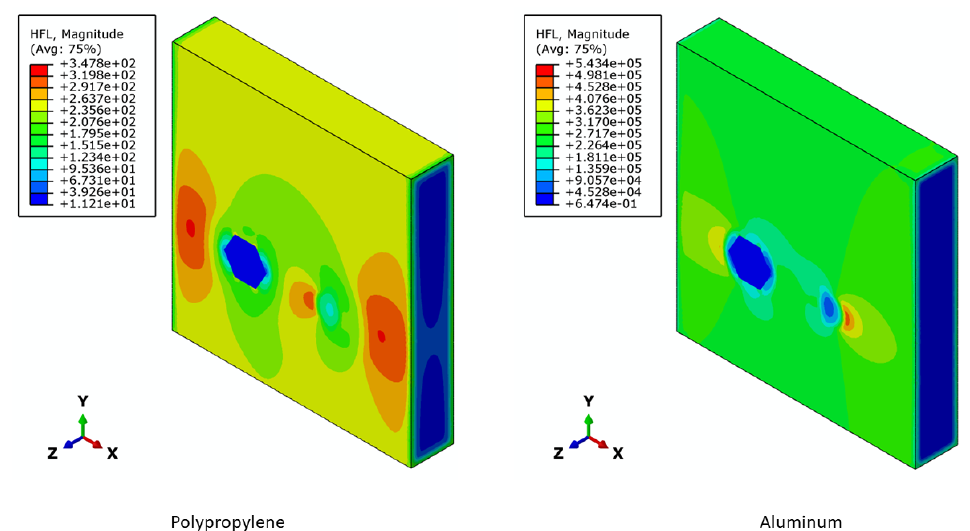
Figure 6. Heat flux in the Y-direction of the camlock model with different materials.